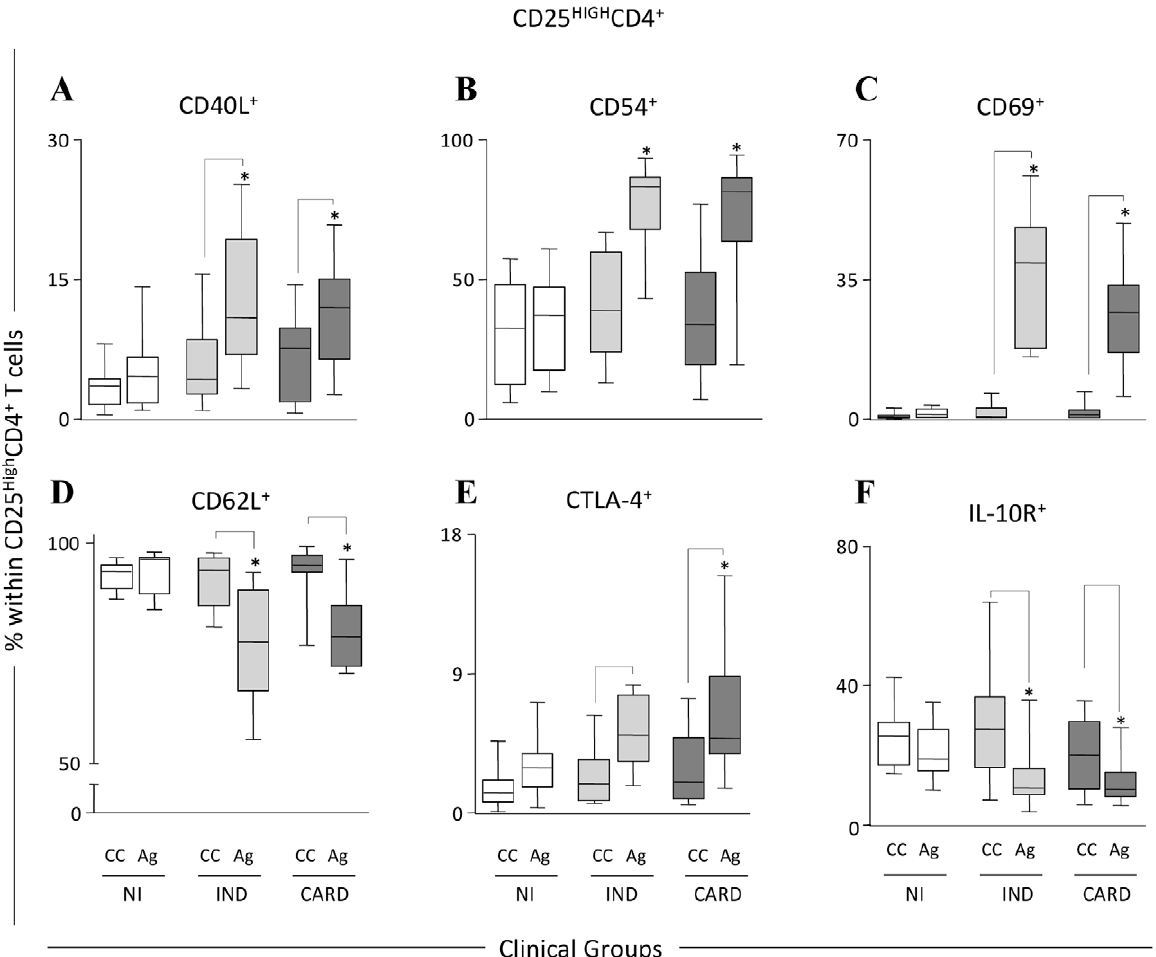
Figure 2. Phenotypic analysis of CD25 High CD4 + regulatory T cells in the peripheral blood from chagasic patients. Phenotypic features of CD25 High CD4 + cells from patients with distinct clinical forms of Chagas’ disease (IND, light gray box; CARD, dark gray box) and non-infected individuals (NI, white box) following short-term in vitro stimulation of whole blood samples with T. cr u zi antigens. Baseline levels for a range of phenotypic features of CD25 High CD4 + cells were obtained from control cultures (CC) maintained under the same conditions (22 h incubation at 37 u C, CO 2 humidified incubator). The results are expressed in box plot format as the percentage of positive cells within CD25 High CD4 + cells including those expressing adhesion molecules CD62L (D) and CD54 (B), co-stimulatory receptors CD40L (A) and CTLA-4 (E), activation marker CD69 (C) and regulatory receptor IL-10R (F). The box stretches from the lower hinge (defined as the 25 th percentile) to the upper hinge (the 75 th percentile) and, therefore, contains the middle half of the score in the distribution. The median is shown as a line across the box. Therefore, 1:4 of the distribution is between this line and the bottom or the top of the box. Significant differences are identified by connecting lines for comparisons between CC and Ag, and highlighted that T. cruzi antigens triggered an overall change in the phenotypic features of CD25 High CD4 + cells towards lower frequency of CD62L + and IL-10R + cells besides increased levels of CD54 + , CD40L + , and CD69 + cells in both IND and CARD groups. Although T. cruzi antigens were able to induce higher levels of CTLA-4 in both groups of chagasic patients (IND and CARD), the impact of T. cruzi antigens was more pronounced in CARD, leading to higher frequency of CTLA-4 + cells in comparison to NI. Adapted from [20].